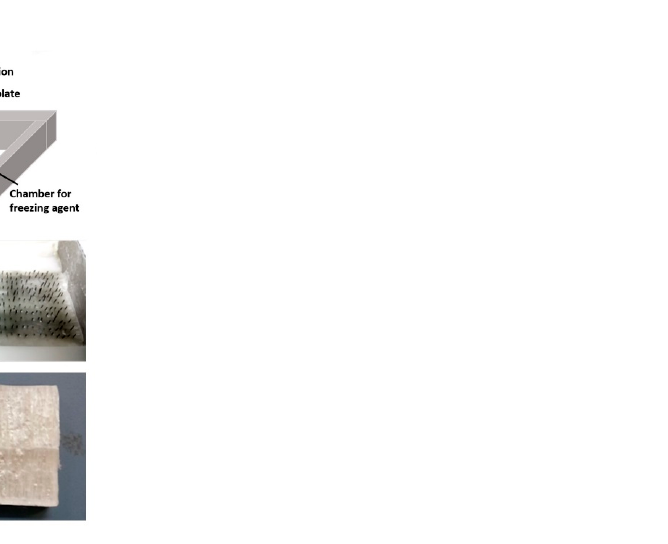
Figure 1. ( A ) Schematic representation of the directional freezing process for the production of anisotropic silk scaffolds; red arrows indicate the freezing direction starting from the two cooled down metal plates ( B ) the freezing process yielded a reproducible freezing front (*) and interconnectivity of the resulting axial pores was ensured by placing a needle array perpendicularly within the silk fibroin solution during freezing (top right), which was removed from the resulting silk scaffold after freeze-drying (bottom).